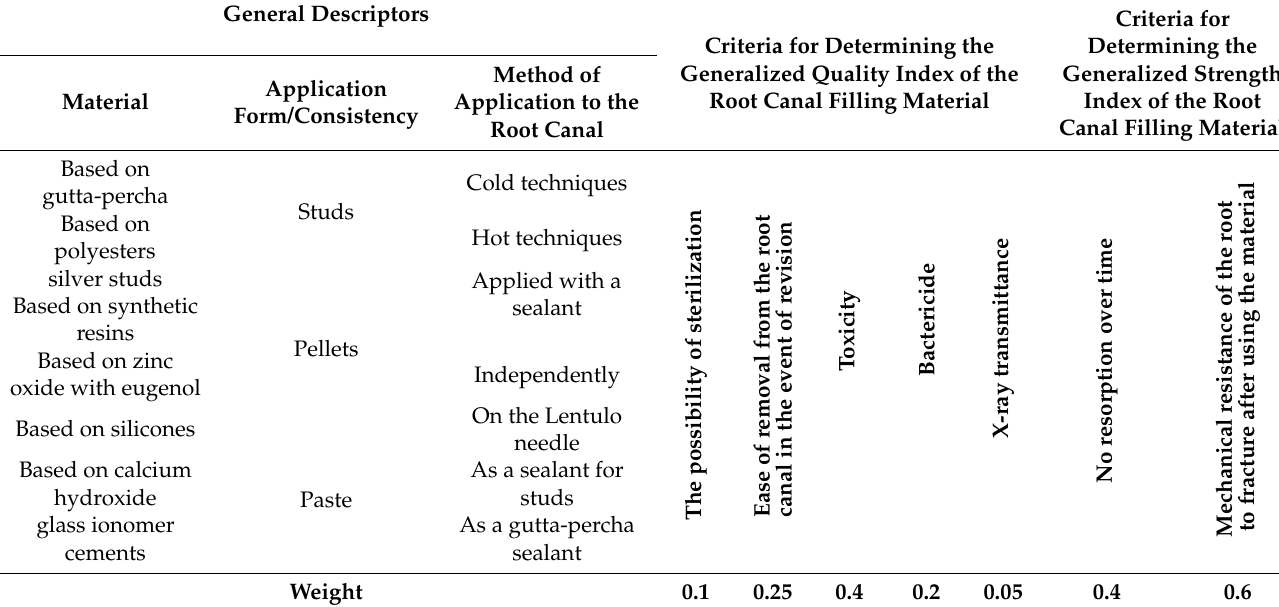
Table 2. The set of criteria adopted for the virtual contextual analysis regarding the selection of the material filling the root canal during endodontic